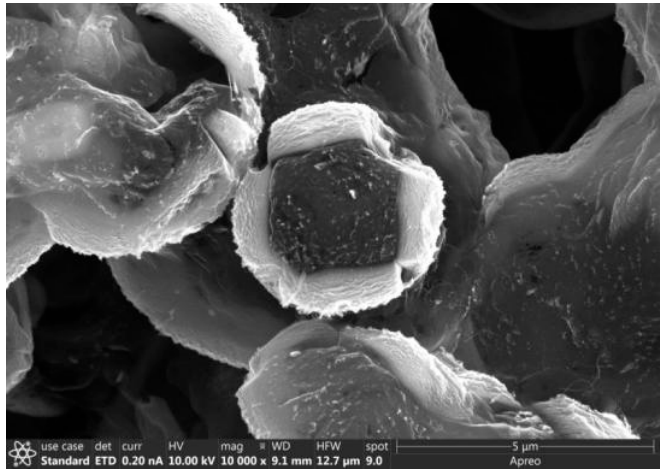
Figure 5. SEM image showing early stage growth of N-GF from boundary of N-3DG flakes.